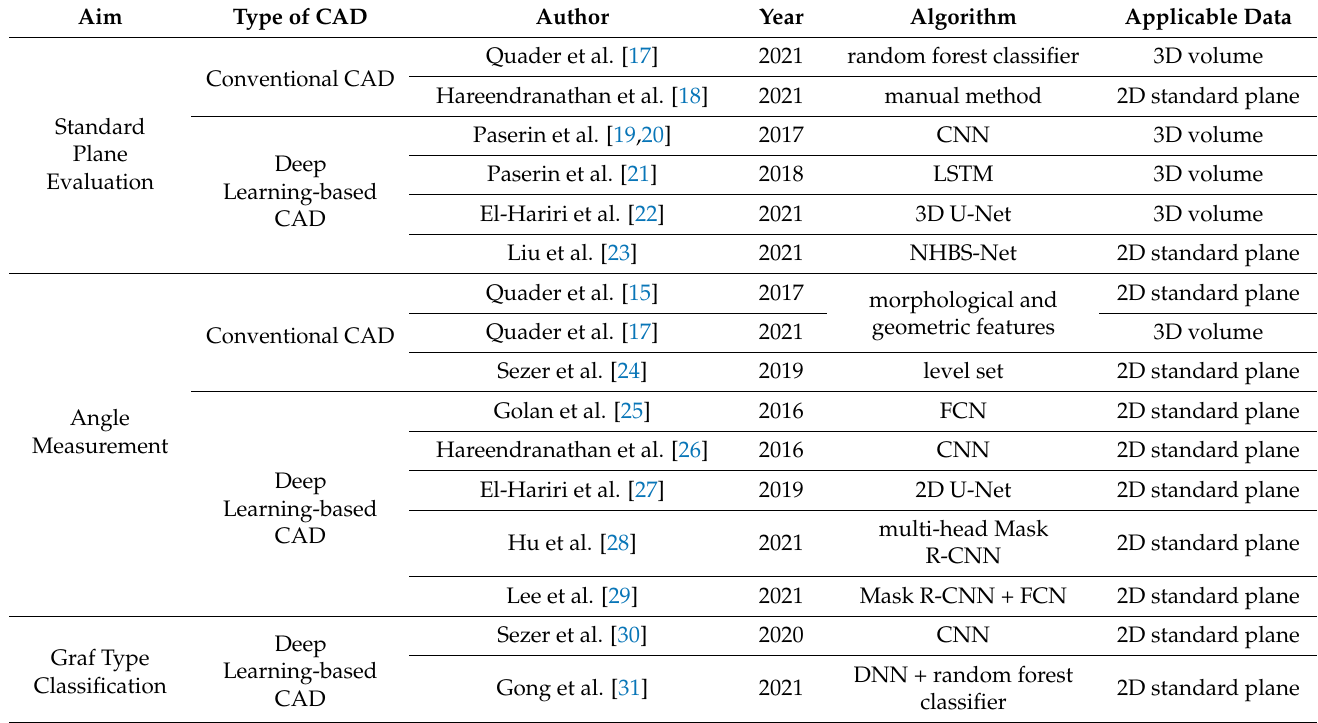
Table 1. Brief presentation of existing CAD methods for the diagnosis of